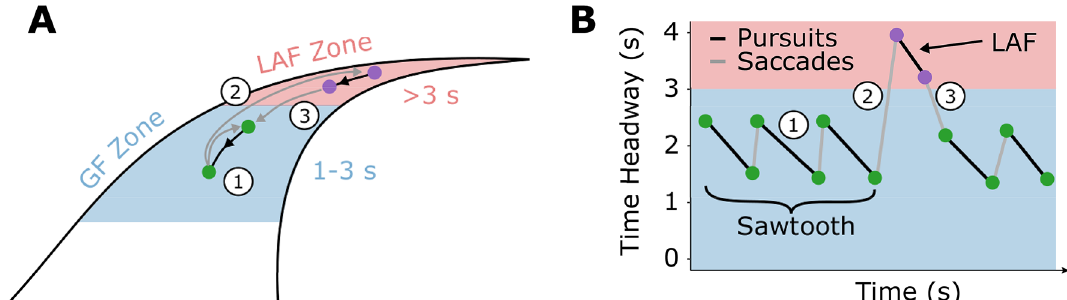
Figure 1. Gaze behaviour during curve driving. ( A ) When actively steering drivers spend most of the time looking at a ‘guiding fixation’ (GF) region 1-3 s ahead, with the occasional look-ahead fixation (LAF)